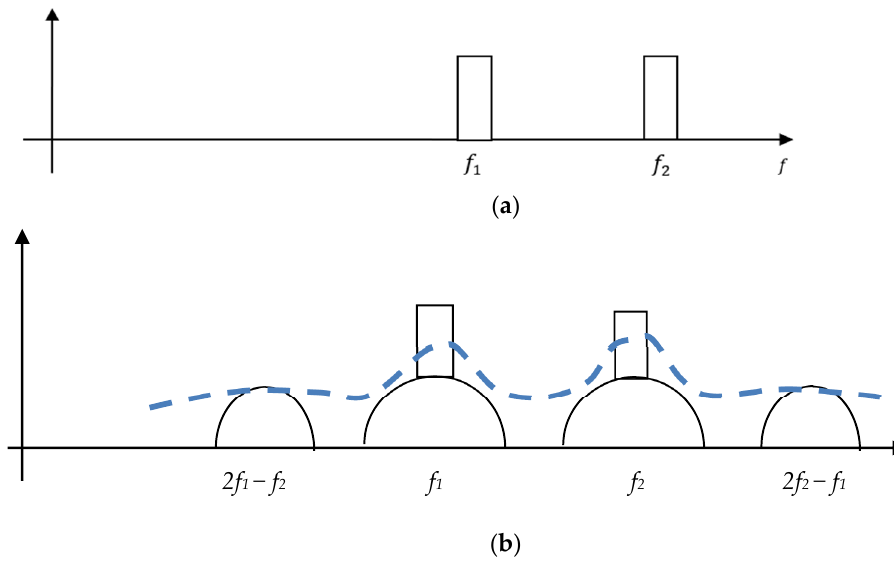
Figure 1. Spectra in a wideband receiver: ( a ) Input spectrum of two RF signals to a passive nonlinearity and ( b ) the Output spectrum; dashed line indicates PSD computed using FFT with rectangular window indicating spectral leakage.